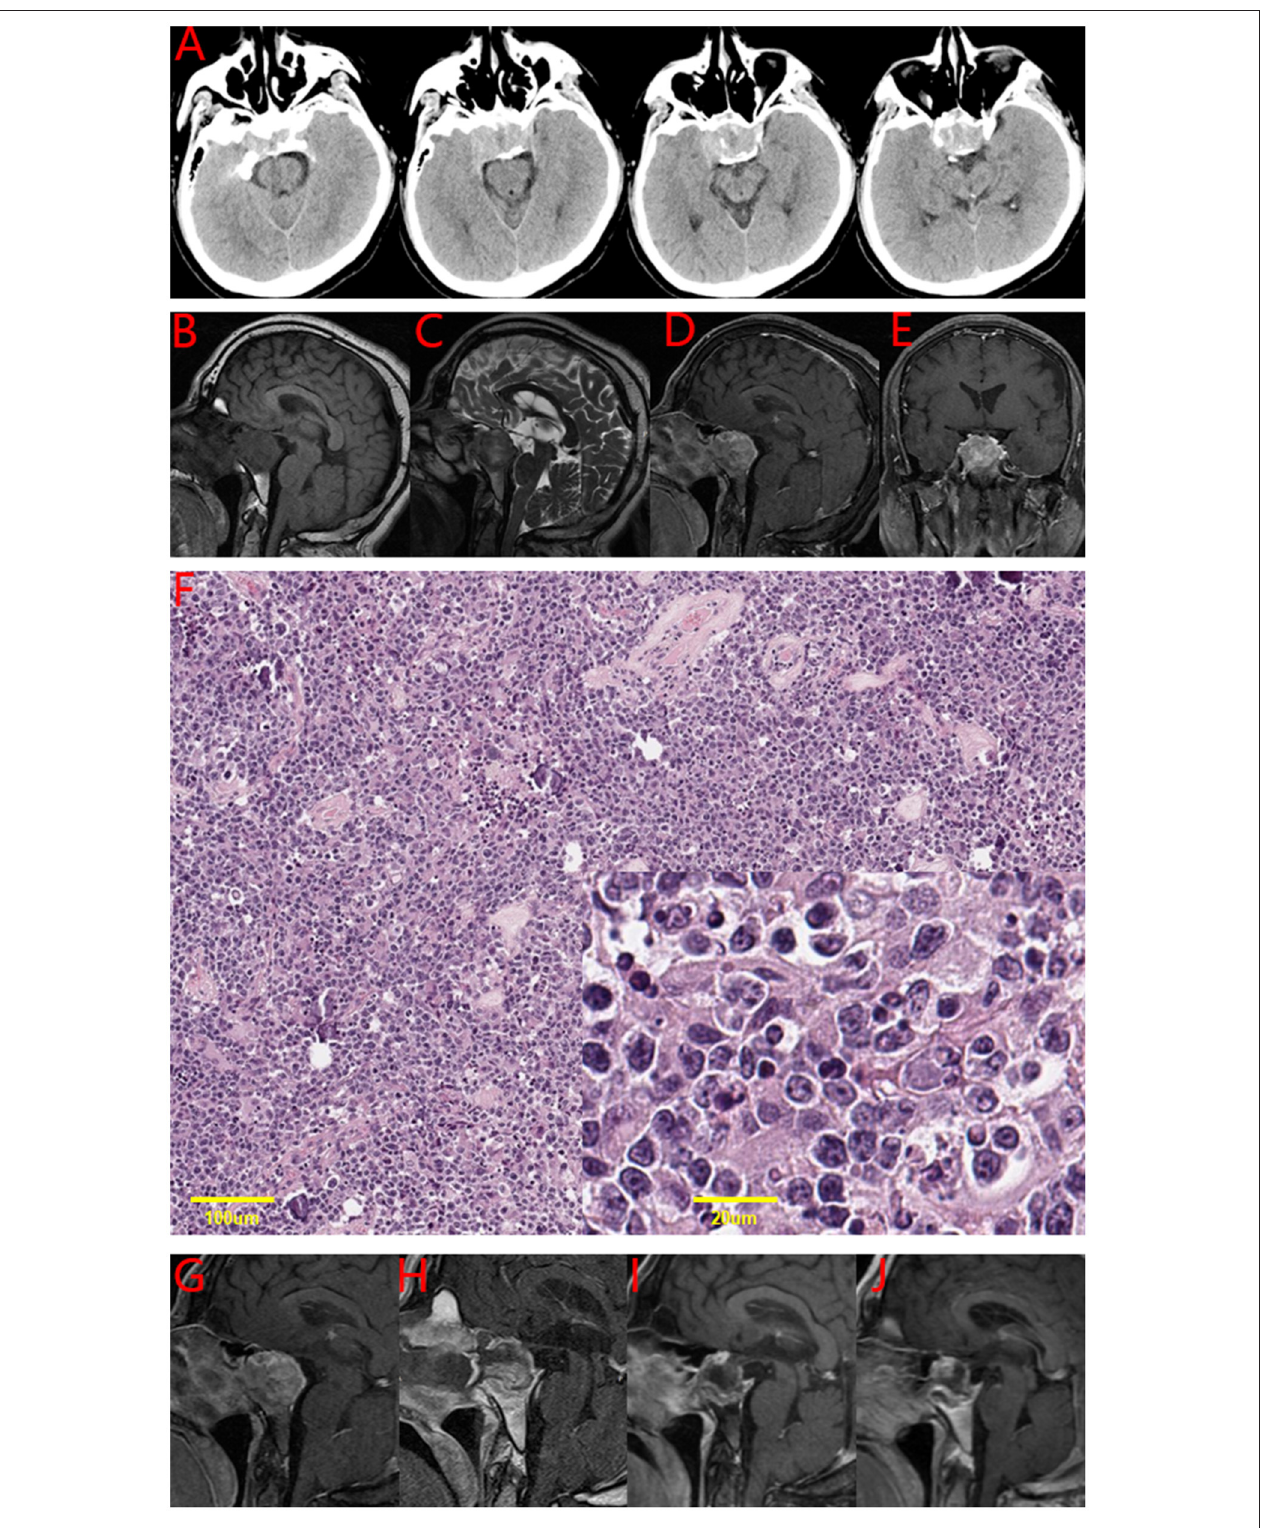
FIGURE 1 | The imaging and pathological results of the patient. (A) Brain CT of the patient in this case. Brain CT showed a tumor in the sellar region with calcification. (B-E) Brain MRI of the patient in this case. (B) T1-weighted image: sellar region tumor is imaged in the same intensity as the cerebral cortex. (C) T2-weighted image: a slightly longer signal. (D) and (E) post-gadolinium image: significant enhancement of under-homogeneity. (F) Hematoxylin and eosin stain of the tumor tissue in this case. Primary pituitary diffuse large B-cell lymphoma combined with sparsely granulated lactotroph adenoma. (G-J) A series of MRIs of the patient in this case. (G) Preoperative (H), postoperative (I), 6 months after the operation (J), and 12 months after the operation.